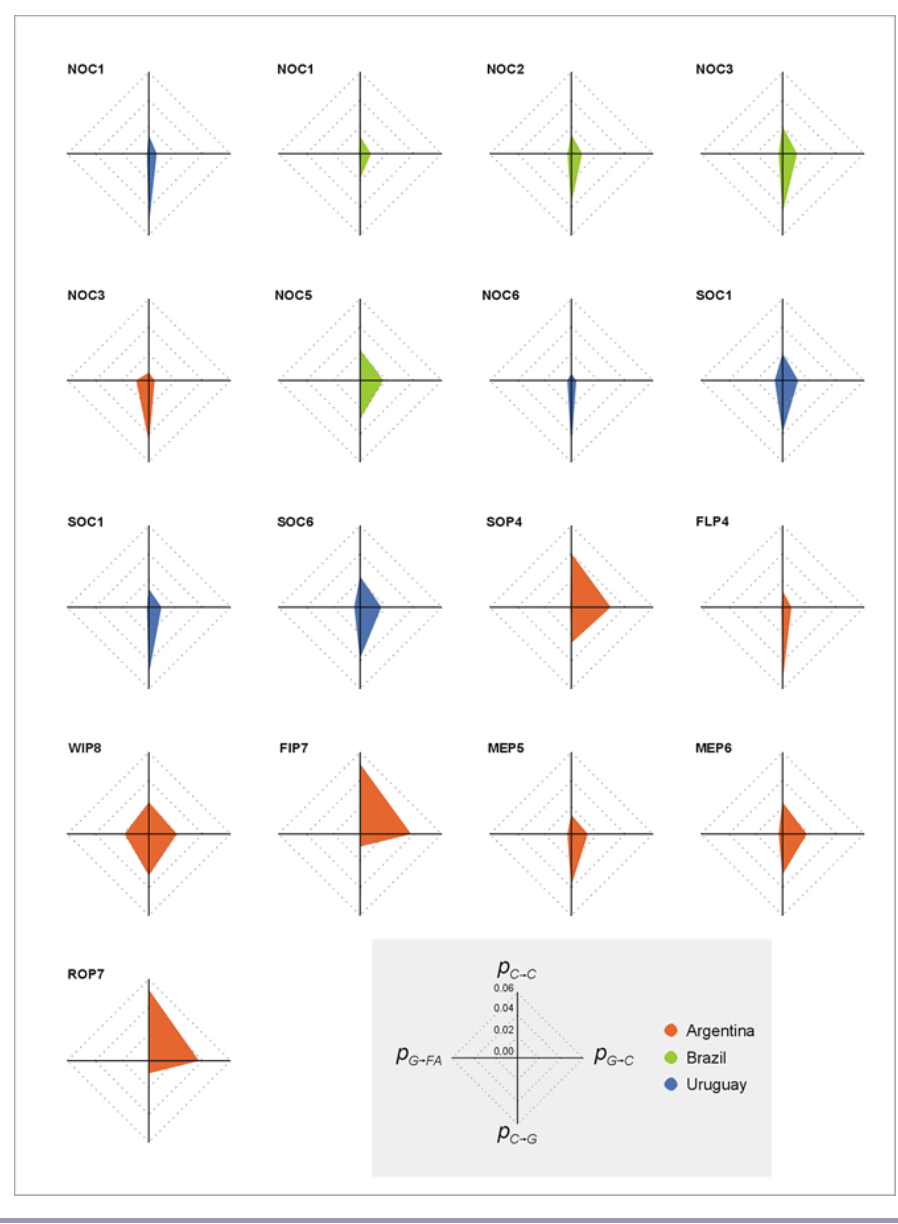
Fig. 5. Transition probabilities for grassland to cropland (G fi C), cropland to cropland (C fi C), cropland to grassland (C fi G), and grassland to forest-afforestation (G fi FA) discriminated by pilot area (Landsat scene), subunit, and country. The abbreviations indicate the subunit (letters) and pilot area (Landsat scene; numerals): NOC = Northern Campos, SOC = Southern Campos, SOP = Southern Pampa, FLP = Flooding Pampa, WIP = West Inland Pampa, FIP = Flat Inland Pampa, MEP = Mesopotamic Pampa, ROP = Rolling Pampa, 1 = 222/083, 2 = 223/081, 3 = 224/080, 4 = 224/086, 5 = 225/082, 6 = 225/083, 7 = 227/083, and 8 = 229/084. The number of grid cells included in each combination is given in Table